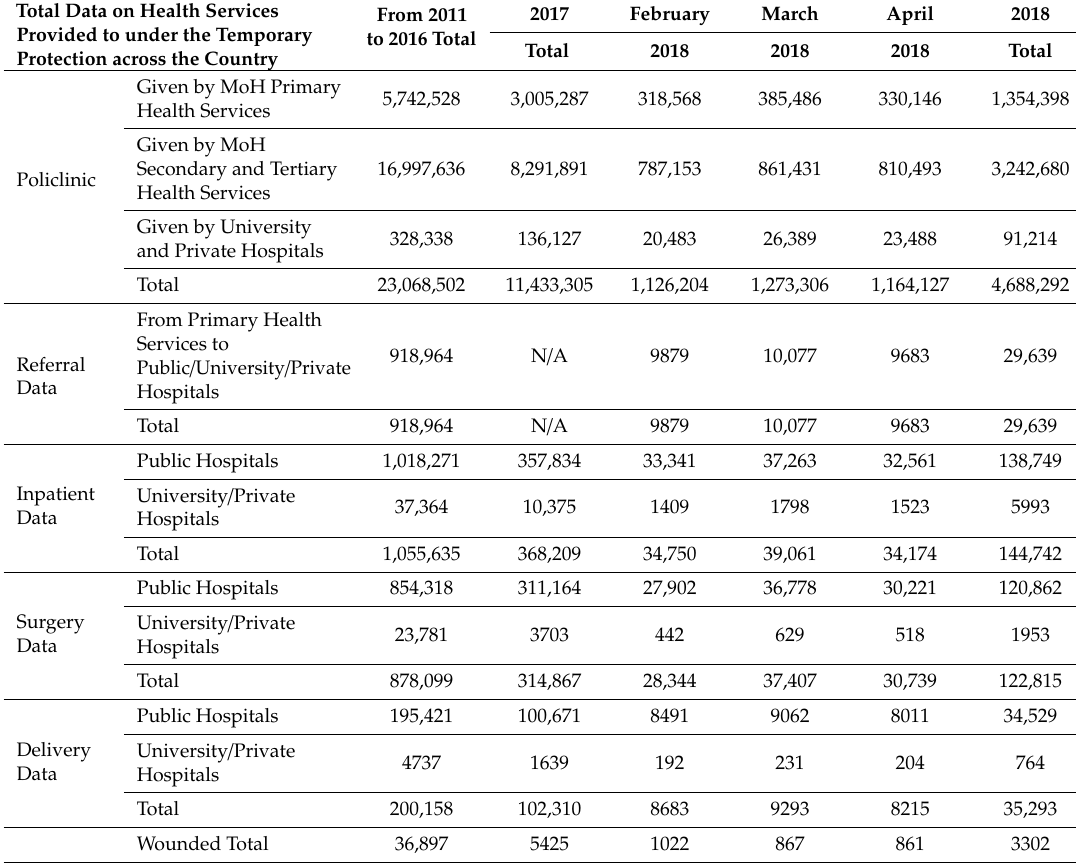
Table 1. Total Data on Health Services Provided to Syrian migrants under Temporary Protection across Turkey (As of 30 April 2018) (Source: Turkish Ministry of Health). Total Data on Health Services Provided to under the Temporary Protection across the